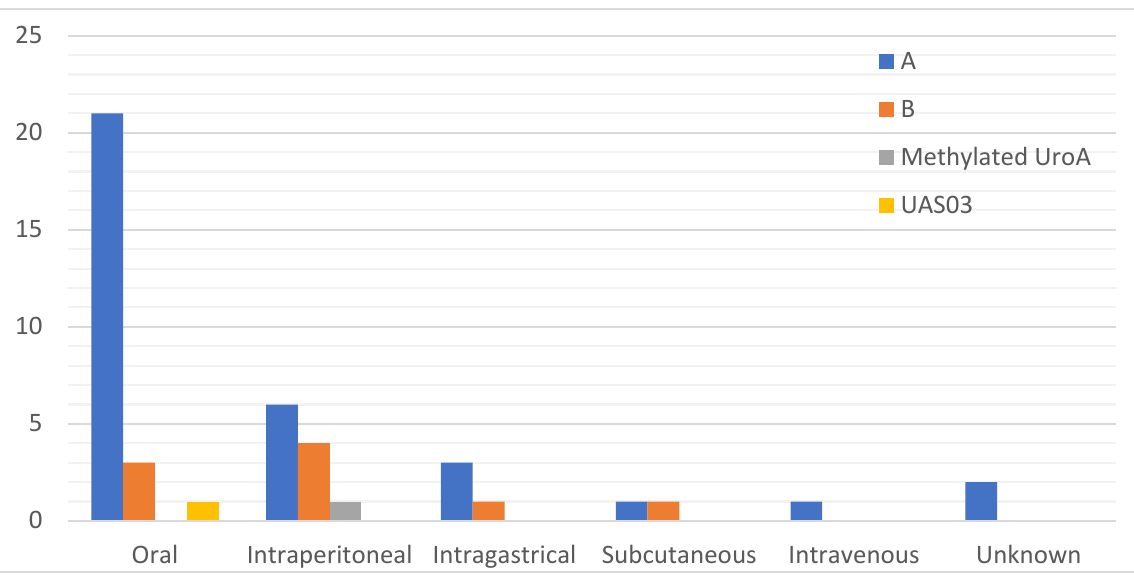
Figure 2. Frequency of the mode of administration route used in the included studies categorised by the type of Uro.